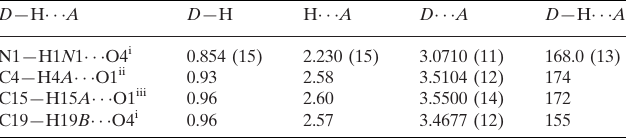
Hydrogen-bond geometry (A˚ , (cid:2)